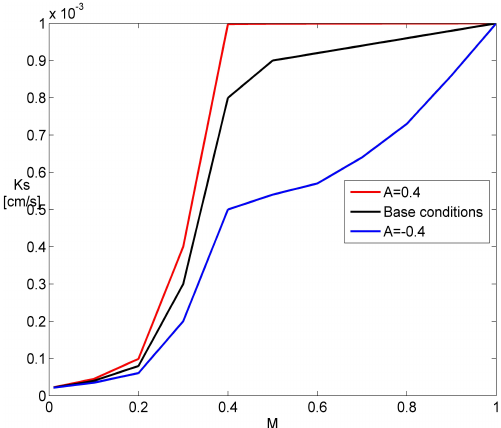
Fig. 18. Hydraulic conductivity functions for the base conditions (black), compared with the functions obtained through Eq. (14) with coefficients A = 0 . 4 (red) and A = − 0 . 4